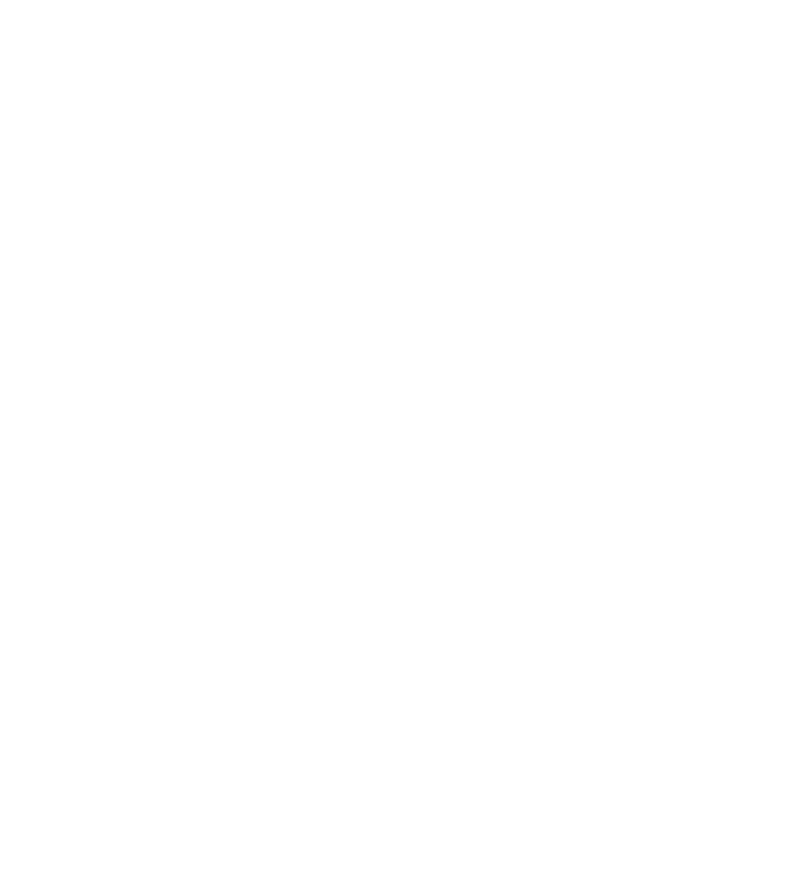
FIGURE A1 | Q-Q Plot of telomere association using Inverse—normal